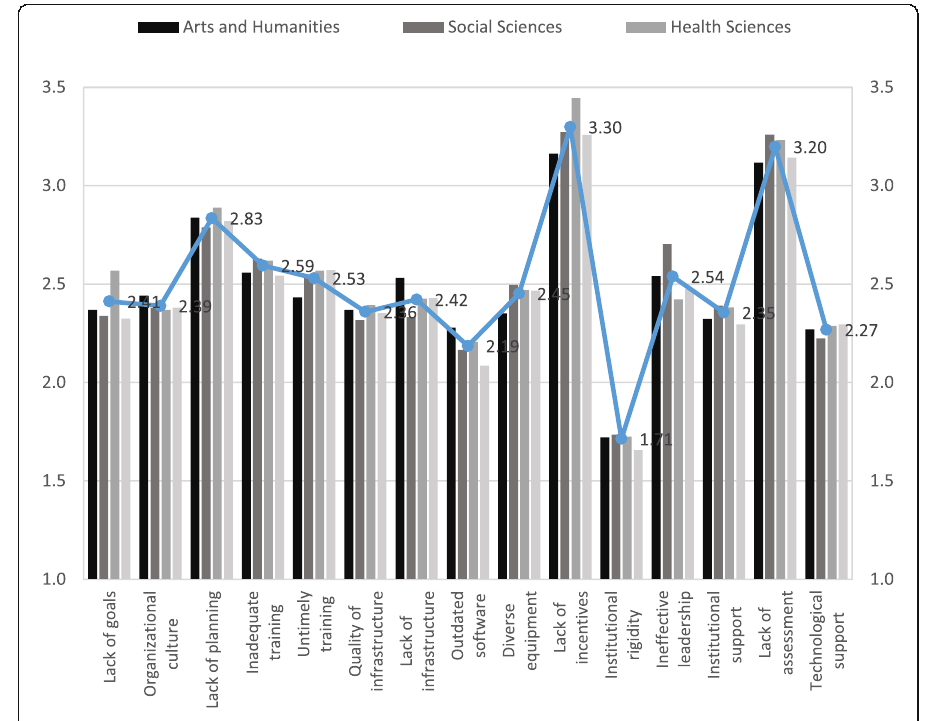
Fig. 4 Mean ranking for institutional barriers to DT integration according to academic discipline